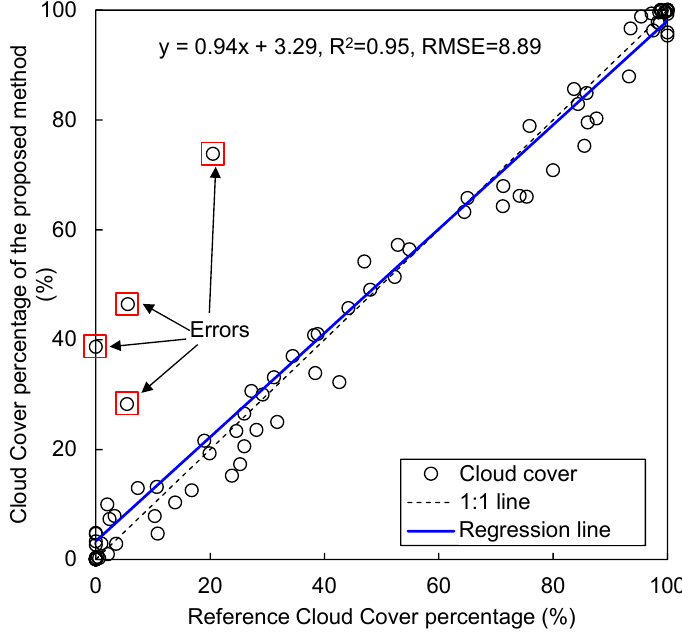
Figure 11. Visual cloud cover vs. detected cloud cover for the all the reference masks in the year 2011.